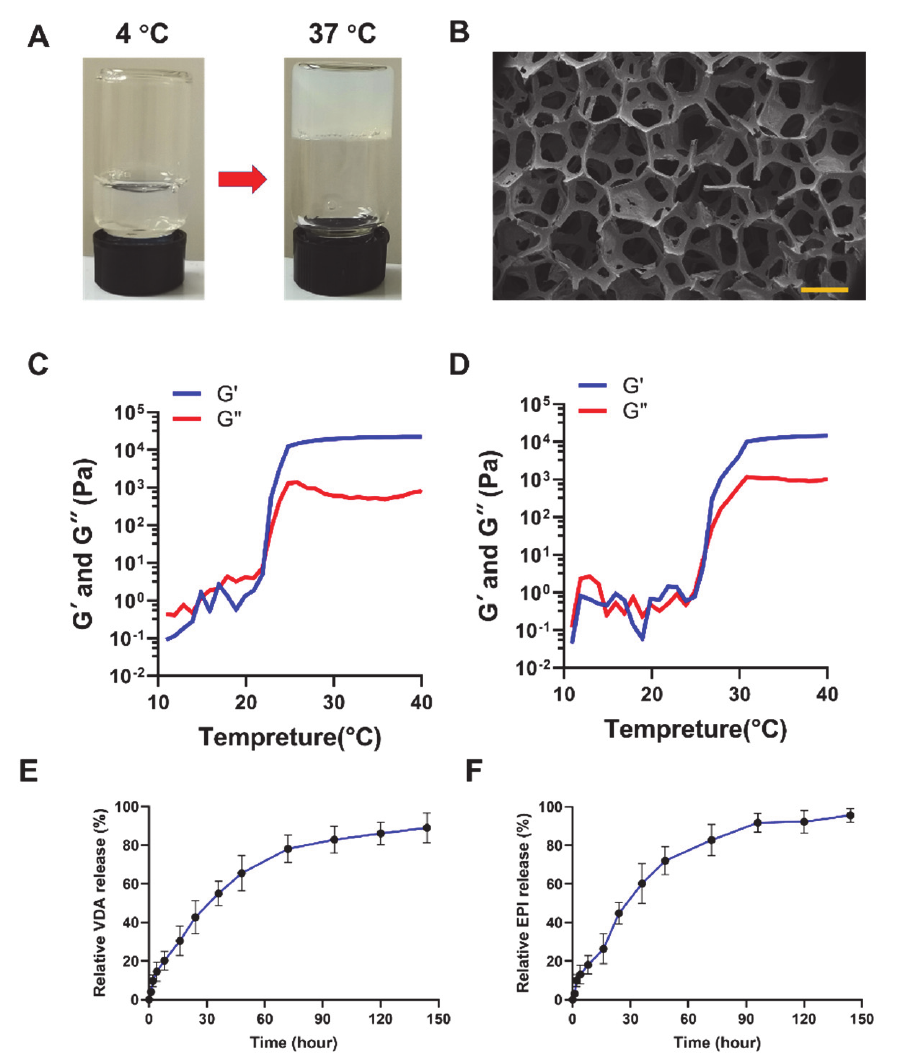
Figure 1. Preparation and characterization of V+E@Gel. ( A ) Representative photos of sol–gel transition of PLGA-PEG-PLGA hydrogel; ( B ) Morphological study of V+E@Gel by cryo-SEM, scale bar = 500 µ m; Dynamic mechanical analysis of ( C ) blank hydrogel and ( D ) V+E@Gel; In vitro release kinetics of ( E ) VDA and ( F ) EPI in V+E@Gel. All data are shown as mean ± S.D. ( n = 3).